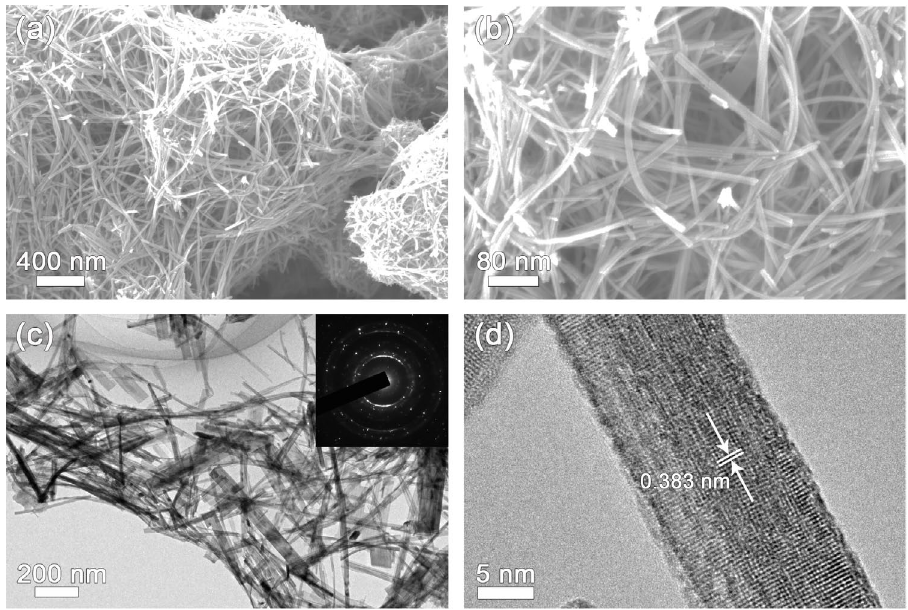
Fig. 4 SEM and TEM images of the annealed sample synthesized in precursor with 0.2 M